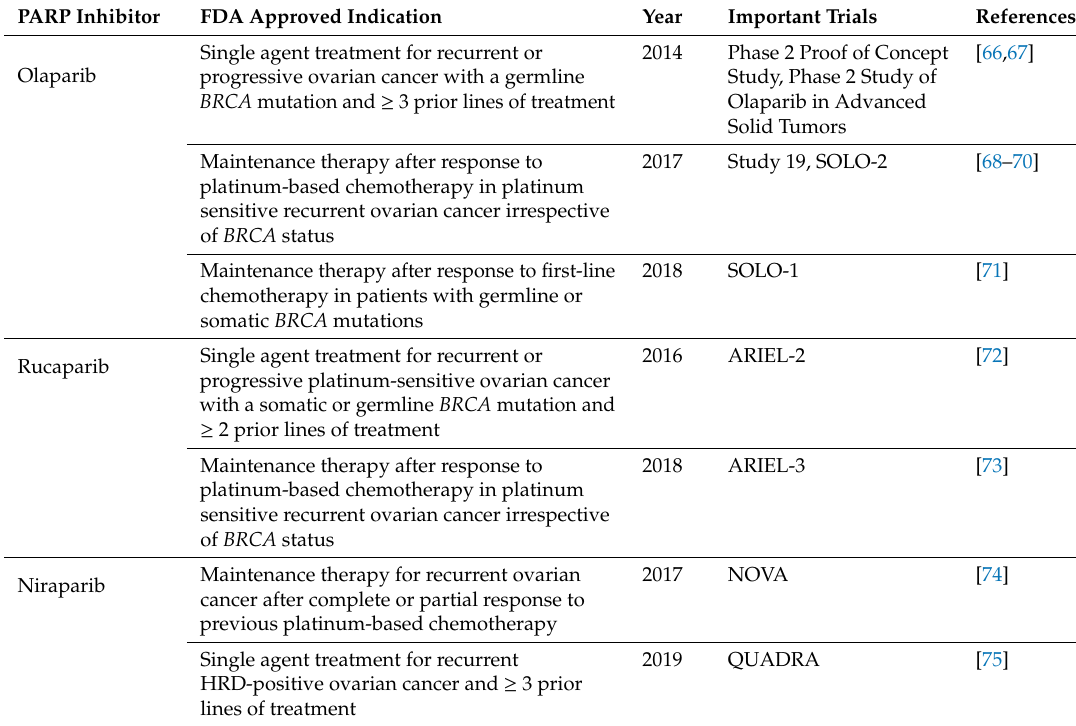
Table 1. FDA-approved indications for PARP inhibitors in ovarian